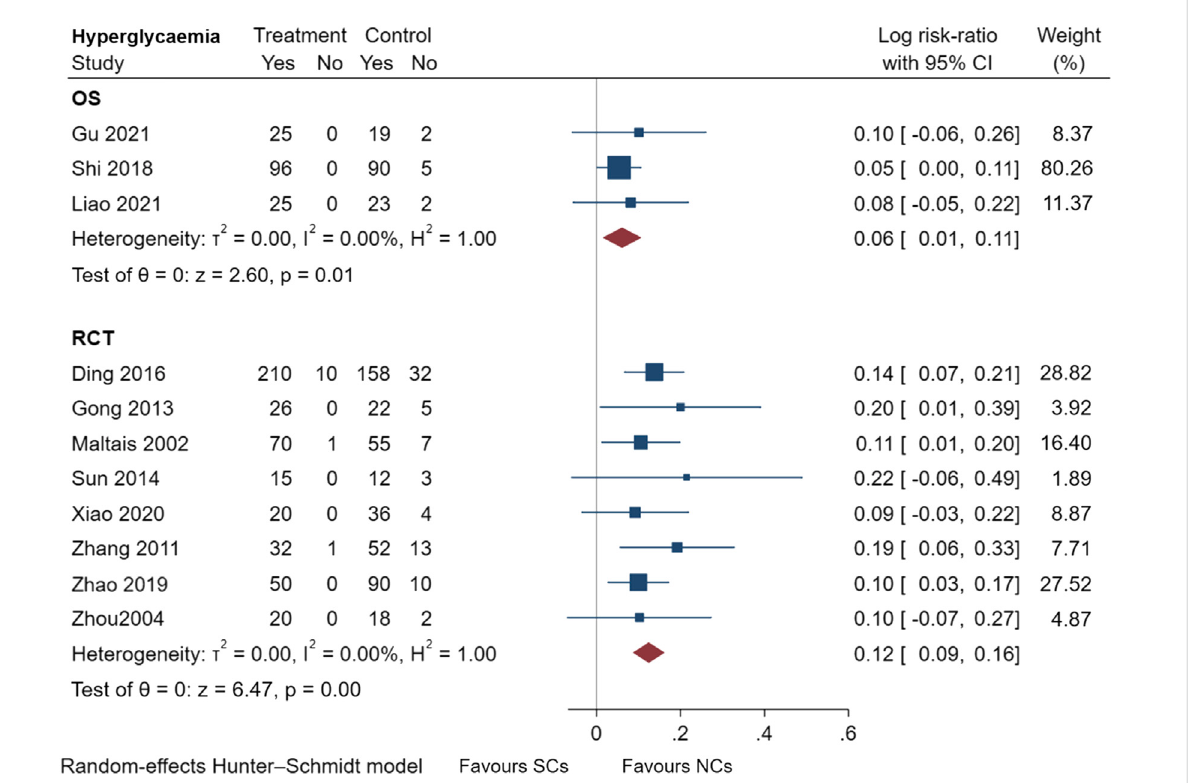
Hyperglycemia events of SCs and NCs in observational studies and randomized controlled